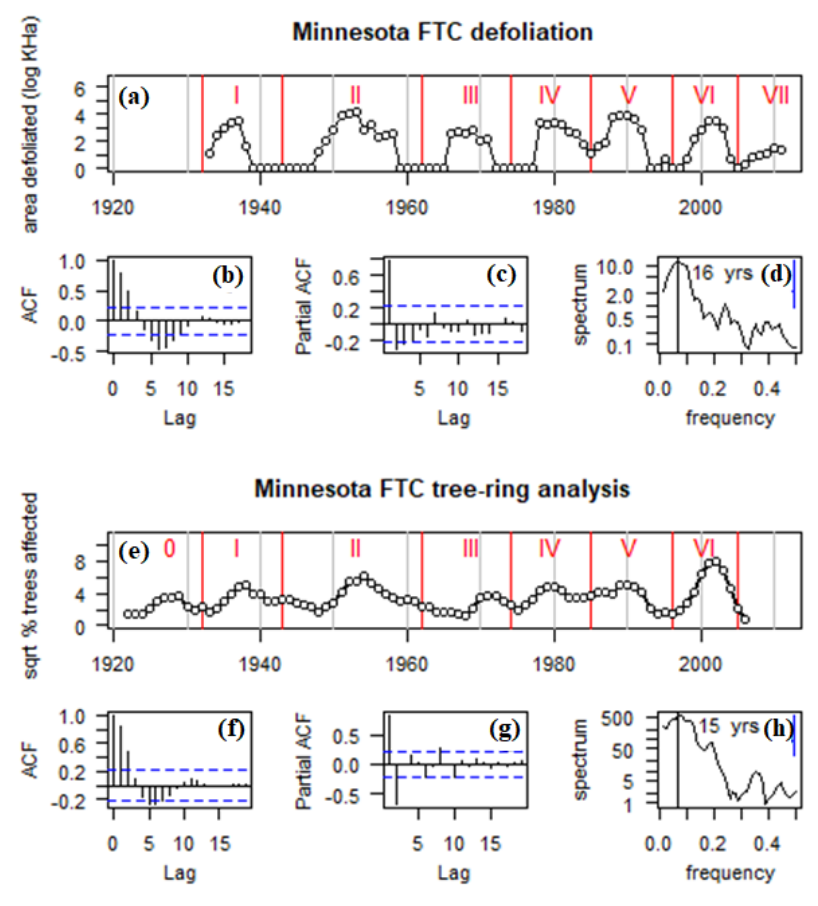
Figure 2. Time series of area impacted by FTC in Minnesota, 1922–2011. ( a ) Area defoliated during cycles I ‐ VII (log10 ‐ transformed + 1). ( b ) Autocorrelation in area defoliated. ( c ) Partial autocorrela ‐ tion in area defoliated. ( d ) Spectrum of area defoliated. ( e ) Square root of the % of trees affected during cycles 0 ‐ VI. ( f ) Autocorrelation in trees affected. ( g ) Partial autocorrelation in trees affected. ( h ) Spectrum of trees affected. Red vertical bars in ( a , e ) indicate cycle troughs, used as time frames in computing maps in Figure 3. The Arabic “0” is used for the first outbreak because this early out ‐ break is in the tree ‐ ring record, before state ‐ wide aerial defoliation sketch ‐ mapping begins. Vertical lines in ( d , h ) indicate spectral peaks.